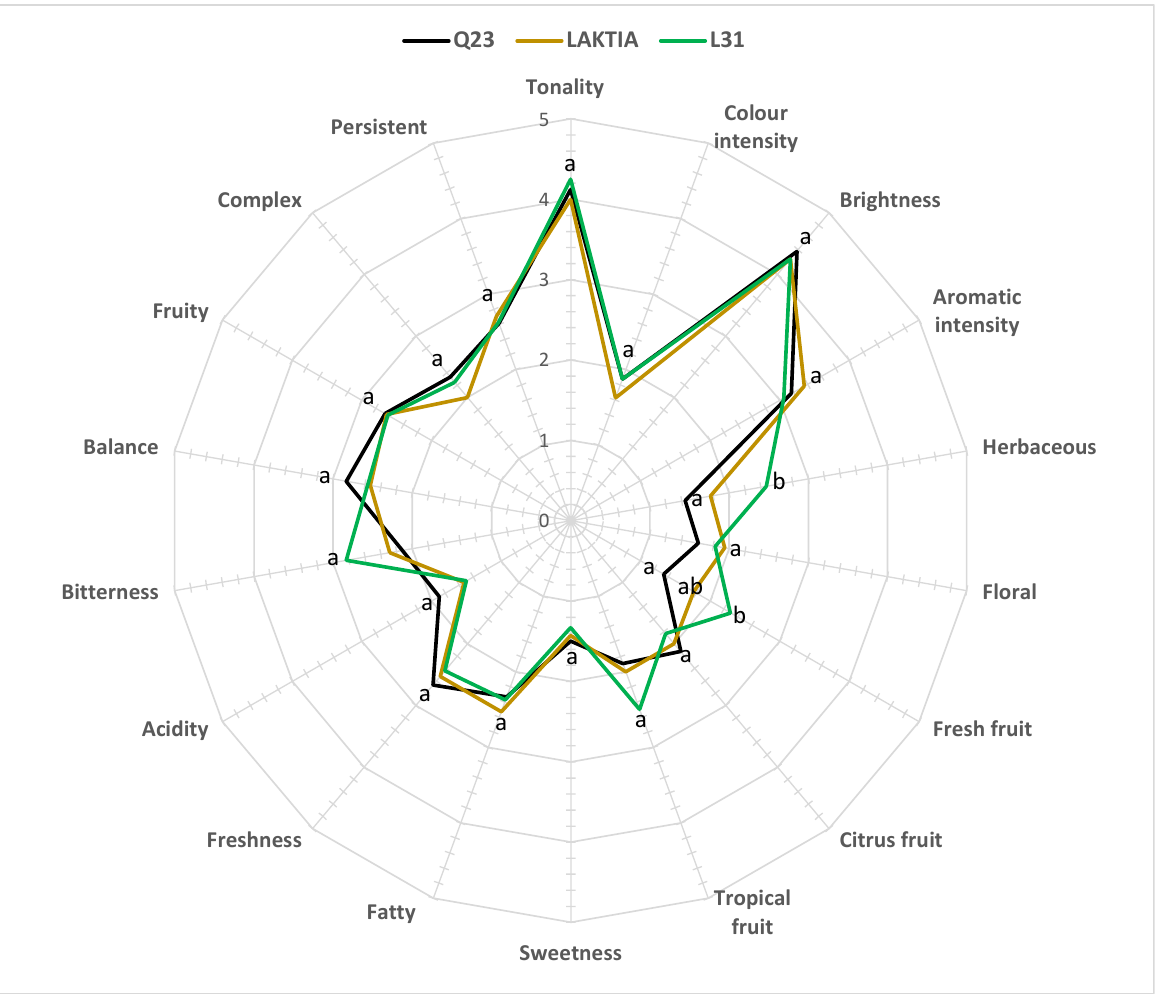
Figure 3. Sensory analysis of wines. The values are the average from nine tasters. The same attributes with the same letter are not significantly different α = 0.05.